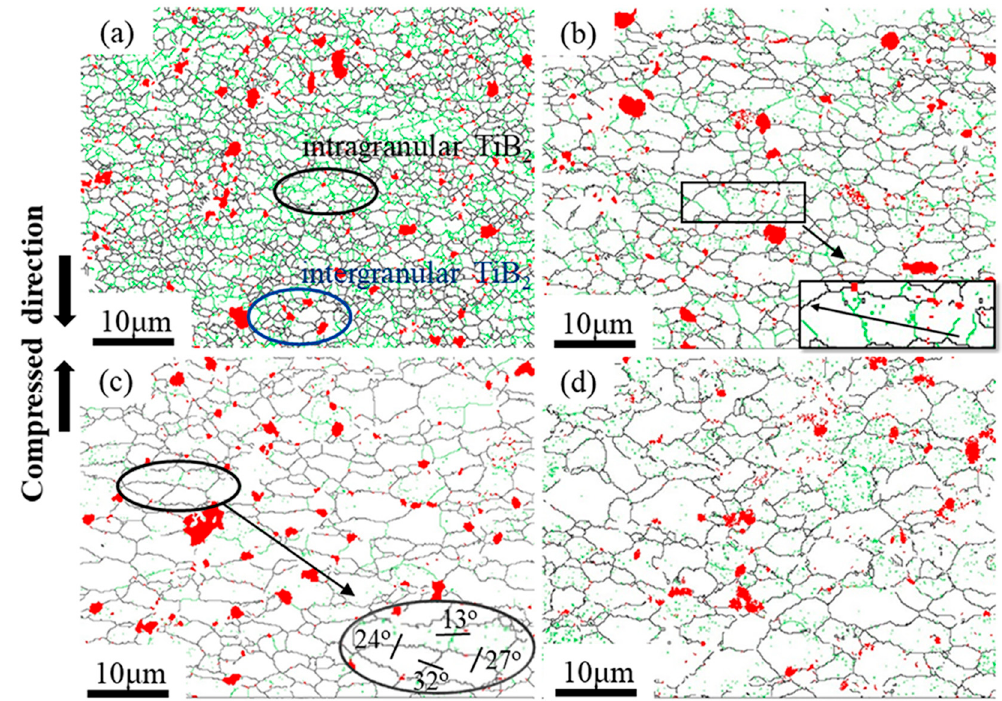
Figure 9. The grain boundary maps of samples under different Z values ( a ) lnZ = 30.0; ( b ) lnZ = 25.8; ( c ) lnZ = 21.7; ( d ) lnZ = 16.6 (the red phase is the TiB 2 particle, low-angle grain boundaries (LAGBs) are in green lines, HAGBs are in black lines and the inset figures are enlarged images of the labled parts).